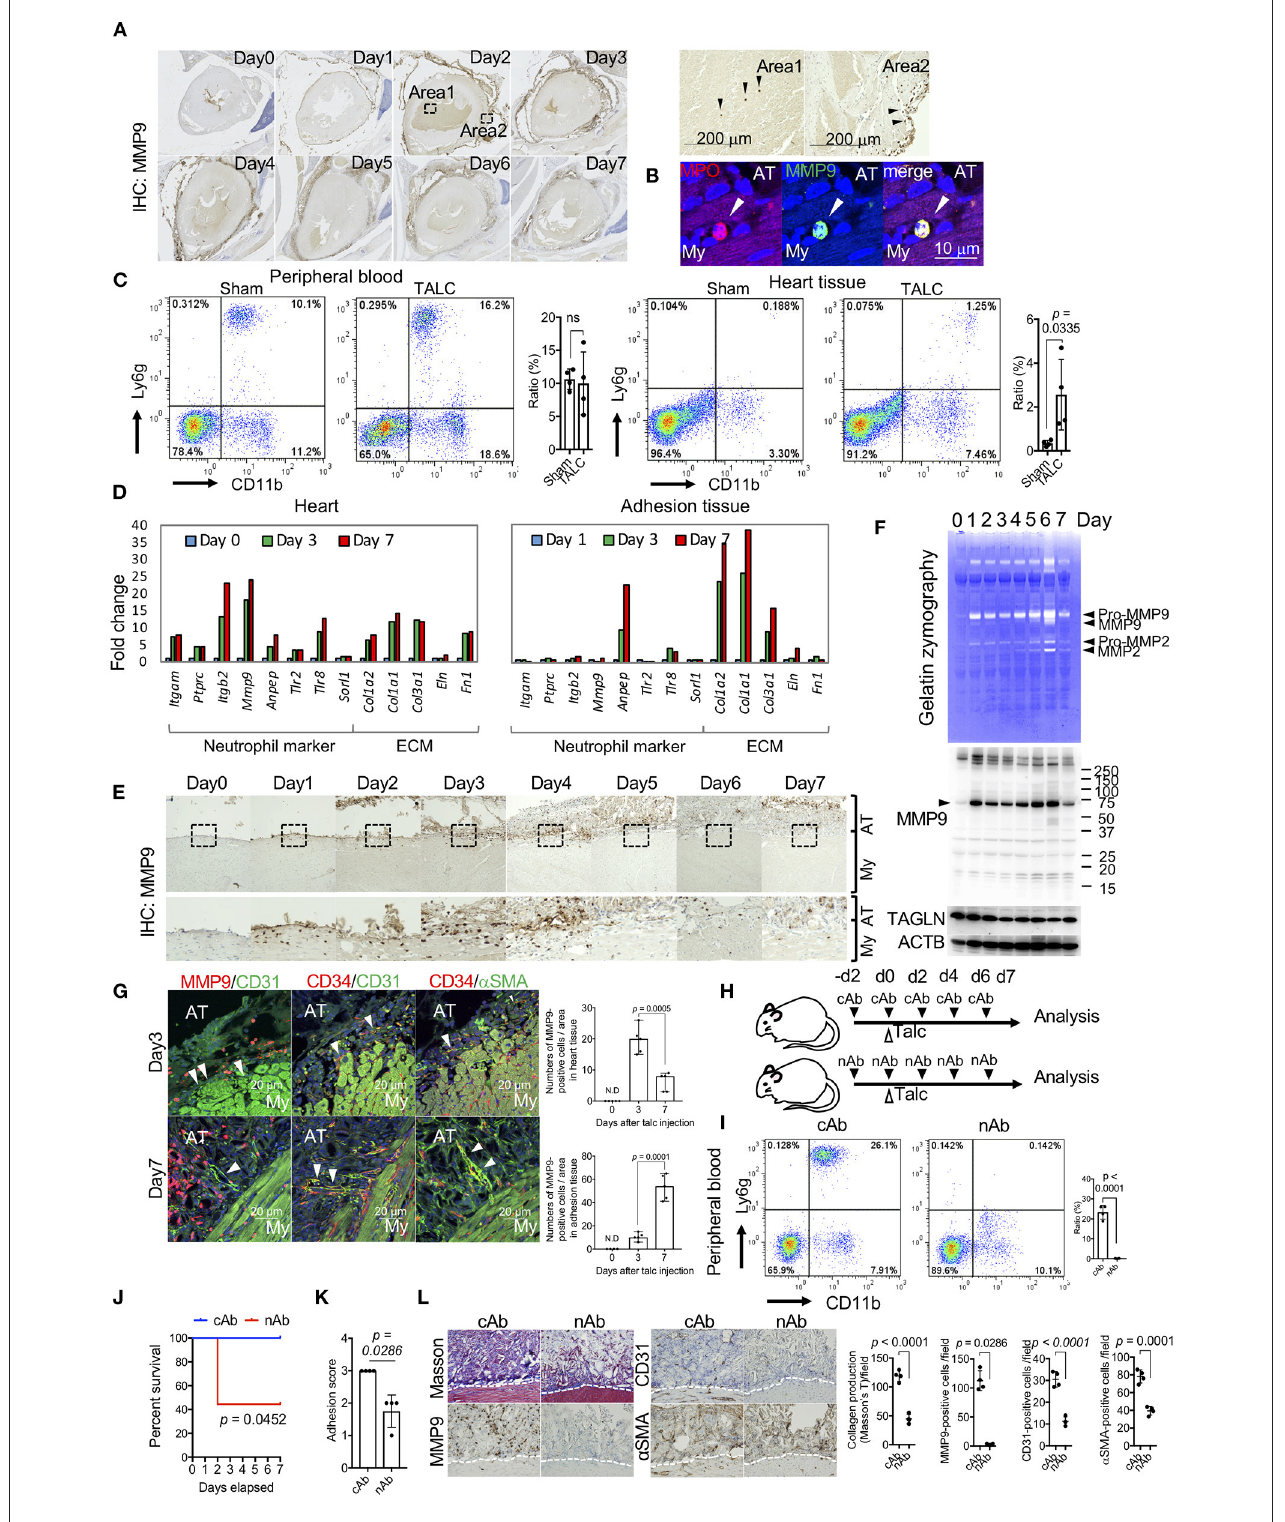
FIGURE 6 | Matrix-metalloprotease-9 (MMP-9)-positive neutrophils on the surface of myocardial tissues is required for unique angiogenesis. (A) Whole heart view after immunohistochemistry (IHC) using anti-MMP9 antibodies. The right panels include magnified images (areas 1 and 2) of areas surrounded by broken lines in the left panels. Arrowheads indicate MMP9-positive cells in area 1 (surface of pericardial tissues) and area 2 (blood). (B) Immunofluorescence co-staining of MPO and